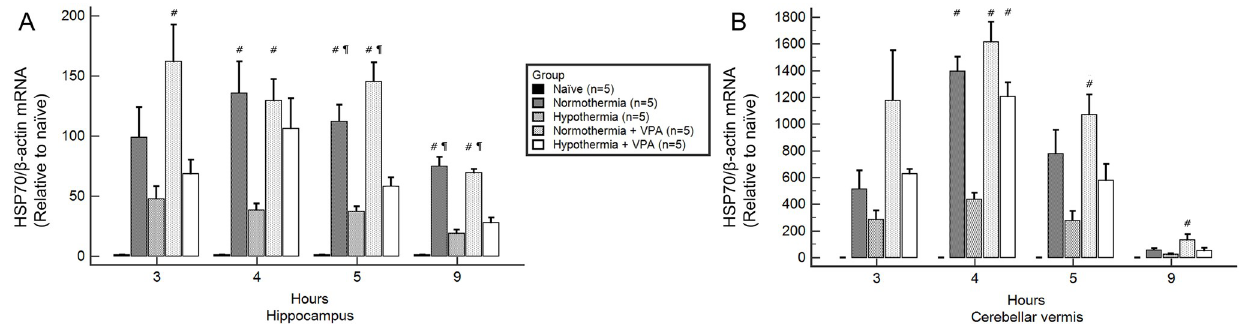
Fig 6. Cleaved caspase-9 of regional brain homogenates obtained at 3, 4, 5, and 9 hours after ROSC by Western blot analysis. At four and five hours after ROSC, only the hypothermia + VPA group showed significantly decreased cleaved caspase-9 levels compared to the normothermia group both in the hippocampus (A) and the cerebellar vermis (B). In the hippocampus, cleaved caspase-9 level in the hypothermia + VPA group was significantly lower than that in the normothermia group until 9 hours after ROSC (B). Bars represent mean ± SEM. Intergroup comparison was performed by one-way analysis of variances with Scheffe´ post-hoc analysis. ¶ , p < 0.05 versus hypothermia + VPA.